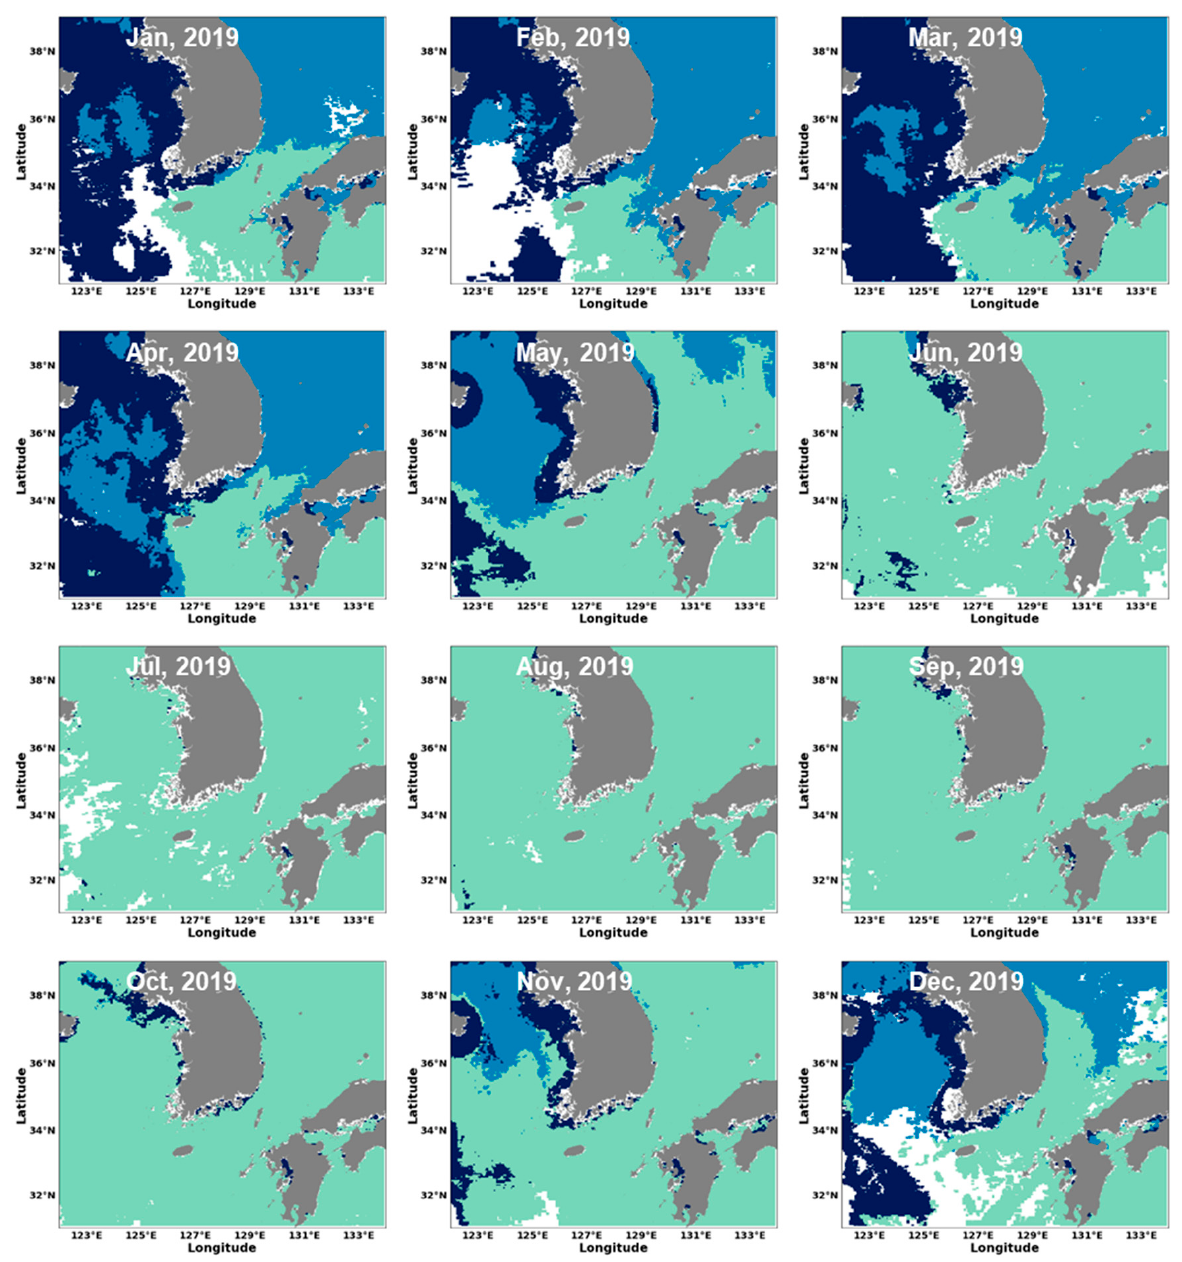
Figure 4. Classification based monthly PSCs distribution using L3 mapped VIIRS data in 2019. White color indicates missing area by cloud. Indigo, blue, and green colors indicate micro ‐ size phytoplankton, nano ‐ size phytoplankton, and pico ‐ size phytoplankton, respectively. Table 4. Matched percent between field measurement Chl-a size fractionated with New AI algorithm (this study), A ph algorithm, and three-component model derived from satellite